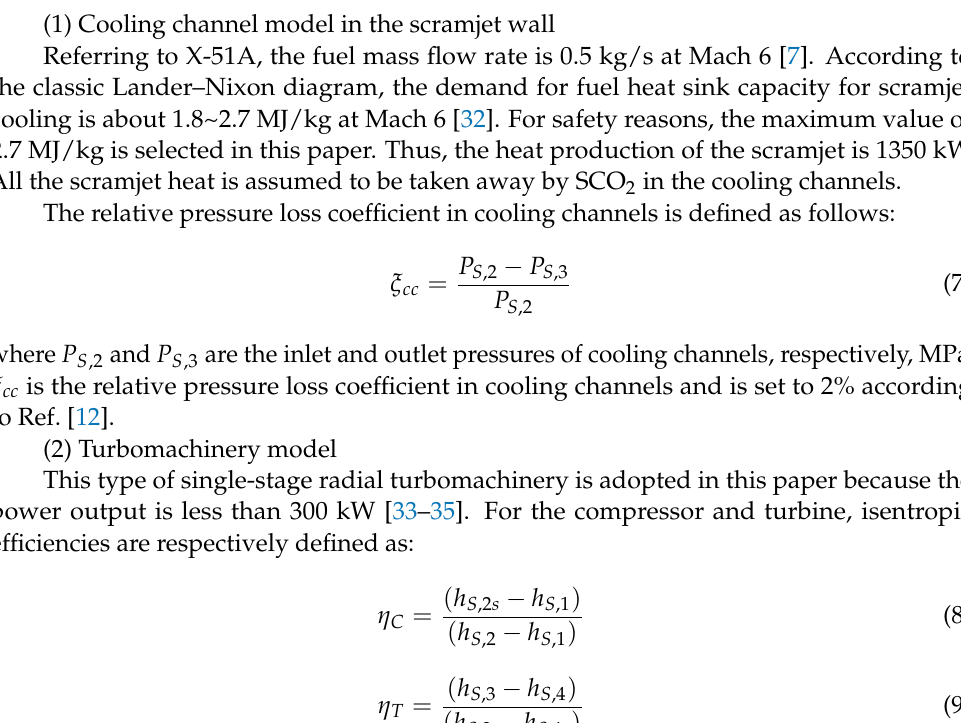
Table 1. Cont . Parameter Value The efficiency of fuel vapor turbine ( η fT ) 0.75 The efficiency of the turbine in the SCO 2 cycle ( η ST ) 0.9 The efficiency of the fuel pump ( η P ) 0.7 The efficiency of the generator ( η G ) 0.9 Pinch temperature difference ( ∆ T min ) ≥ 10 ◦ C The initial power-to-weight ratio of PCHE ( PWR ) 10 Maximum temperature of SCO 2 cycle ( T max ) <1000 Relative pressure loss coefficient of PCHE ( ξ hx , s ) in system-level optimization 2% Maximum relative pressure loss coefficient of PCHE ( ξ hx ) 2% Maximum relative pressure loss coefficient of cooling channels ( ξ cc ) 2% Heat dissipated from the scramjet wall at Mach 6 ( Q total ) 1350 kW Lift–drag ratio 2.95 TSFC (s − 1 ) 0.001 Inlet pressure of the cold side of PCHE ( P c , n ) 5 MPa Inlet pressure of fuel pump ( P p , in ) 0.1 MPa Flight duration 1 h Pressure drop ratio of fuel vapor turbine ( π fT ) 3 Compressor inlet pressure ( P S 1 ) ≥ 7.4 MPa Compressor pressure ratio ( π C )